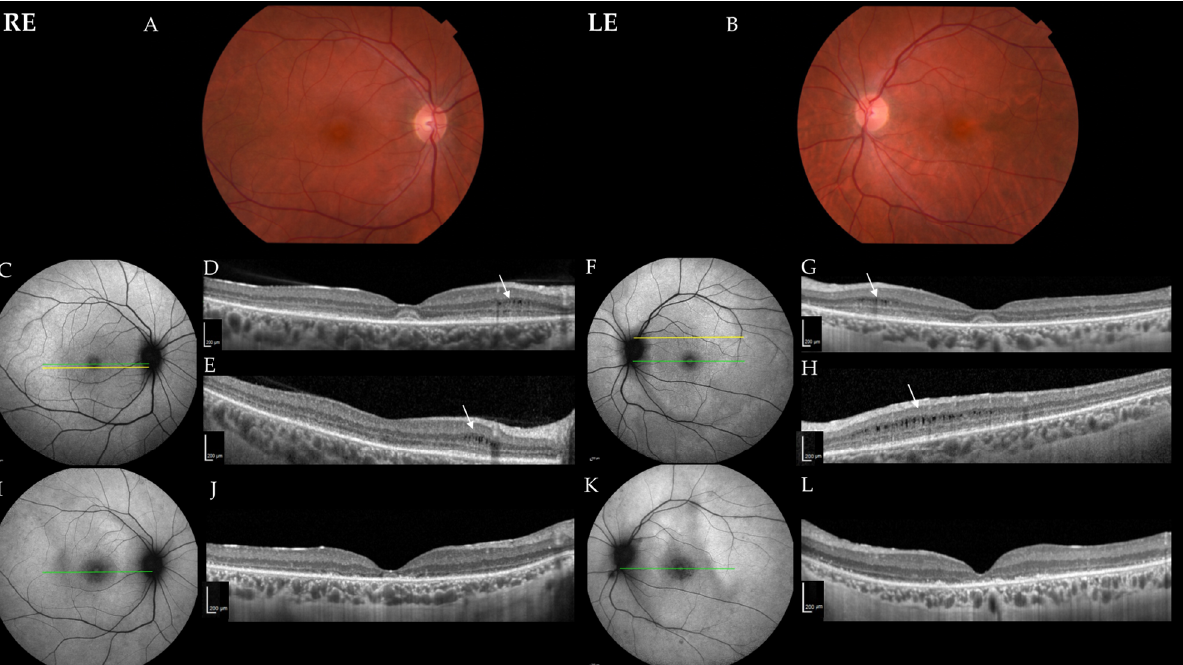
Figure 1. Color fundus photos and progression of DRAM2 retinopathy in Patient 1. ( A , B ) Color fundus photos at the age of 35 years; ( C , F ) fundus autofluorescence imaging (FAF) and ( D , G ) optical coherence tomography (OCT) images at the age of 35 years; ( E , H ) more peripheral OCT images at the age of 35 years; ( I , K ) FAF and ( J , L ) OCT images at the age of 37 years. Green lines in the FAF images show the location of the corresponding OCT scans in images ( D , G , J , L ). Yellow lines on the FAF images show the location of the corresponding OCT scans in images ( E , H ). Note the intraretinal cysts in images ( D , E , G , H ) (white arrows). On follow-up, the disappearance of the foveal photoreceptors ( J , L ) on and widening of the hypoautofluorescence in the fovea ( I , K ) is seen. Abbreviations: RE—right eye; LE—left eye.